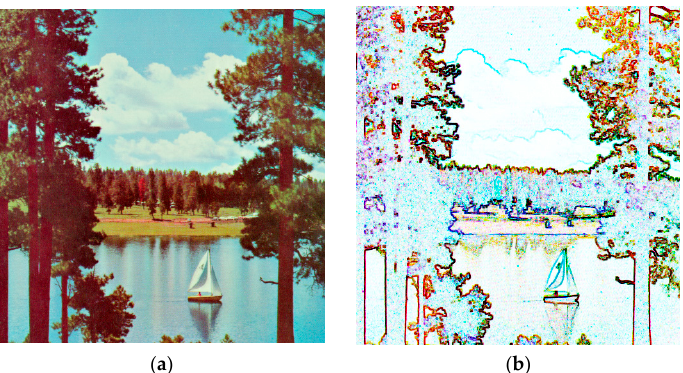
Figure 4. Output color edge detection based on the gradient approach. ( a ) Input image; ( b ) edge detection output.